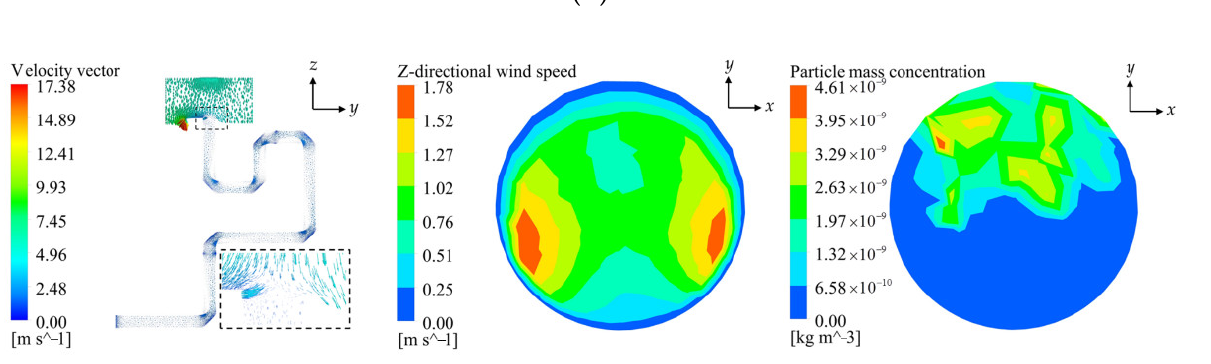
( b ) Figure 4. Variation curves of sealing indicators for the large-aperture channel with different l when  a z v variation curves with L for different l ; ( b ) the c variation curves with L for different l .